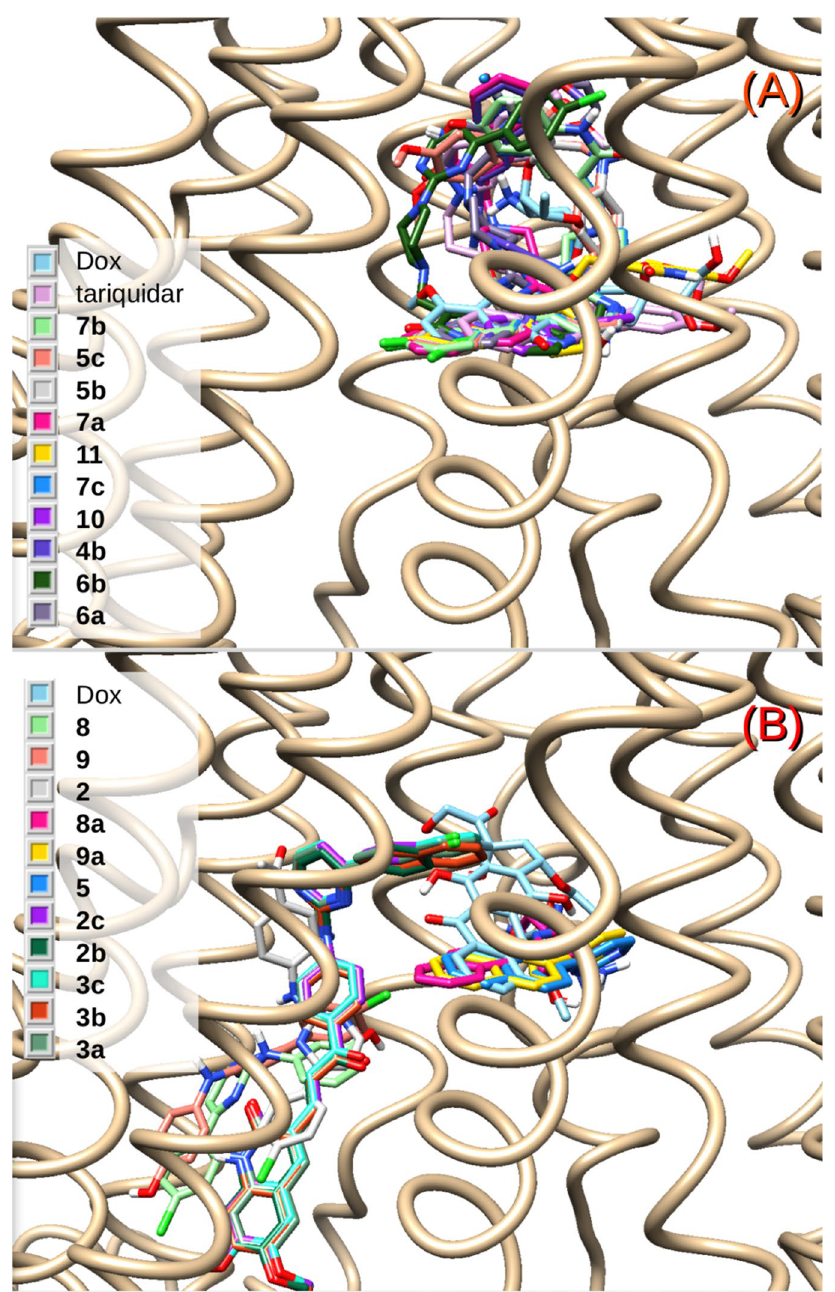
Figure 6. ( A ) Superimposition of the docked structures of the active compounds 4b , 5b–c , 6a–b , 7a–c , 10 and 11 , together with the chemotherapeutic substrate doxorubicin and tariquidar. ( B ) The same for poor or inactive compounds 2 , 2b–c , 3a–c , 5 , 8 , 8a , 9 and 9a